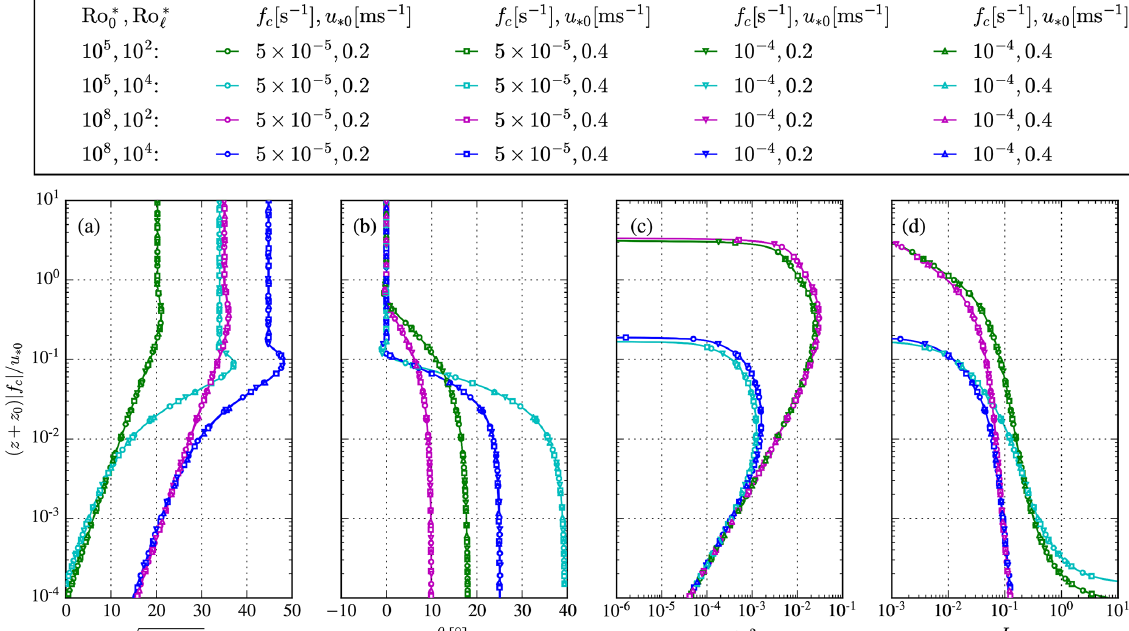
Figure B2. Rossby number similarity of the limited-length-scale k – ε model using the friction velocity as the velocity scale, for Ro L